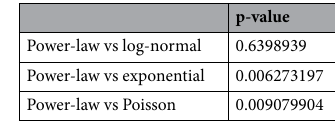
Table 1. Vuong’s likelihood ratio